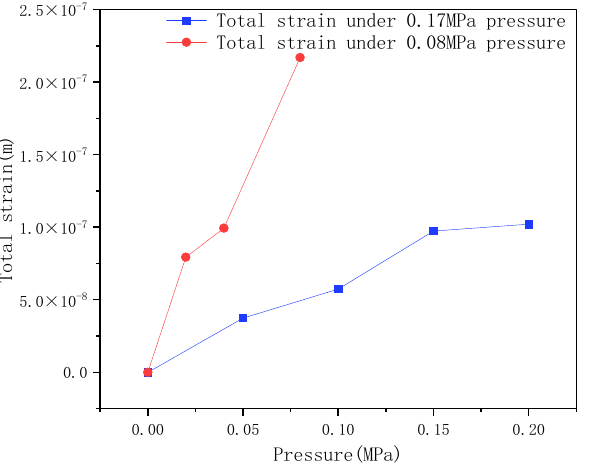
Figure 4. Total deformation of molecular sieve bed under 0.08 MPa (a) and 0.17 MPa (b) pressures. Under the pressures of 0.8 bar and 1.7 bar, the molecular sieve bed shows different deformation, and the specific deformation is shown in the broken-line diagram in Figure 5. 65